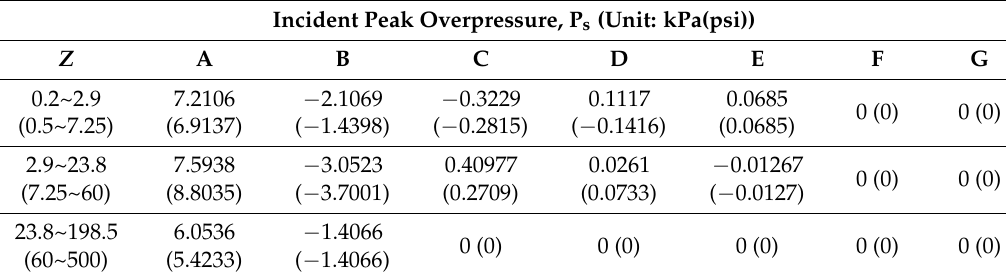
Table 2. Constants for the Incident Peak Overpressure (Swisdak Equation)